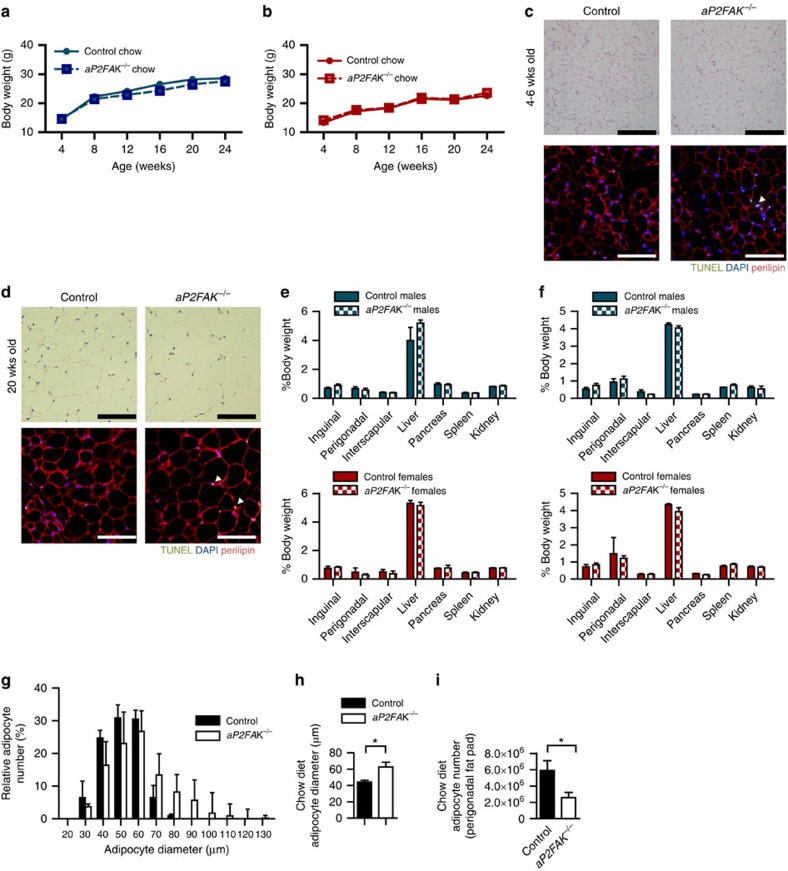
FAK is required for adipocyte survival.(a,b) Body weight in male (a) and female (b) littermate control or aP2FAK−/− mice fed chow diet (n=10). (c,d) Representative haematoxylin and eosin (H&E) and TUNEL of perigonadal WAT sections from 4- to 6-week-old mice (n=3 mice) (c) and 20-week-old mice (n=4 mice) (d) (black scale bar, 100 μm; white scale bar, 100 μm, arrows indicate positive nuclei). (e,f) Body composition expressed as per cent total body weight in 4- to 6-week- (n=5) (e) and 20-week-old (f) male (blue) and female (red) mice (n=6 males, 5 females). (g–i) Adipocyte size distribution (g), average adipocyte diameter (h) and calculated total adipocyte number (i) in 20-week-old mice (n=4 mice). Data are mean±s.e.m. *P<0.05 by Student's t-test between means.